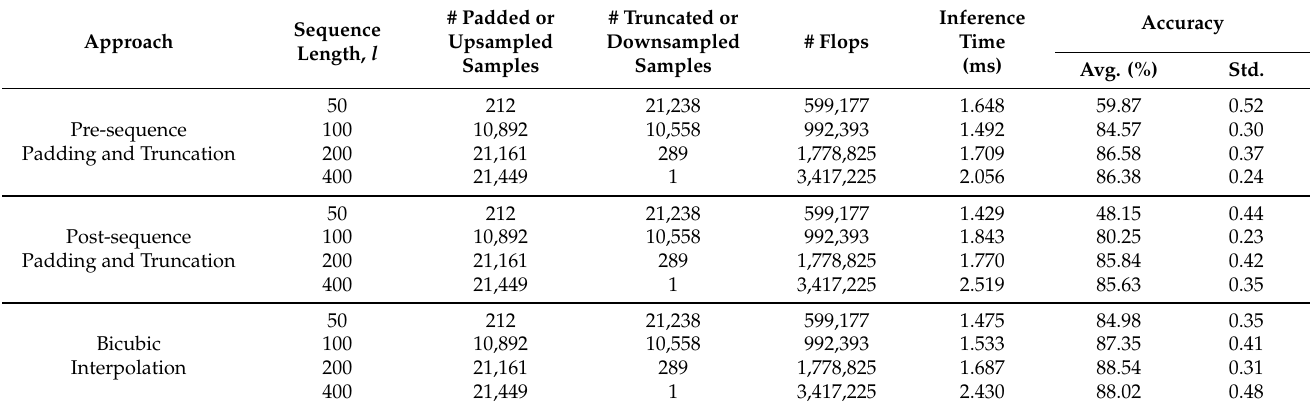
Table 4. Comparative analysis of Bicubic interpolation with padding and truncation methods.